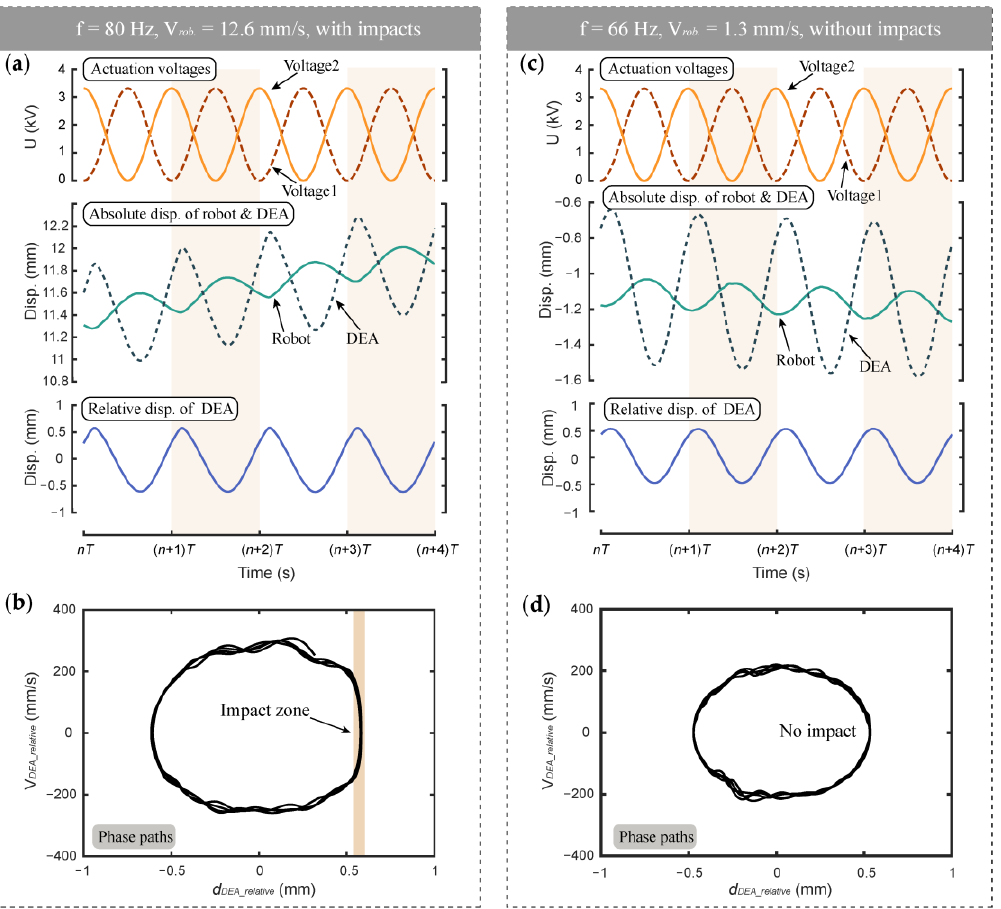
Figure 8. ( a ) Time series of the measured displacements and ( b ) phase paths of the relative DCDEA oscillation at 80 Hz with impacts; ( c ) Time series of the measured displacements and ( d ) phase paths of the relative DCDEA oscillation at 66 Hz without impacts.